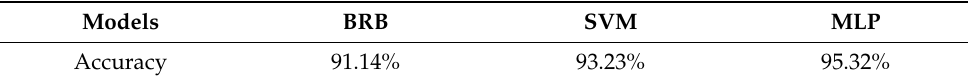
Table 15. The comparison of